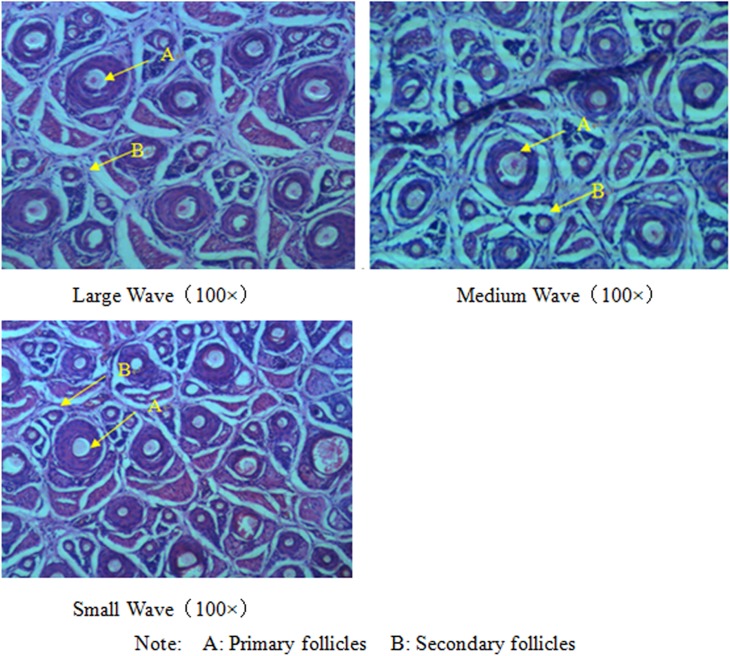
Transverse section images of hair follicles in large, medium and small waves.